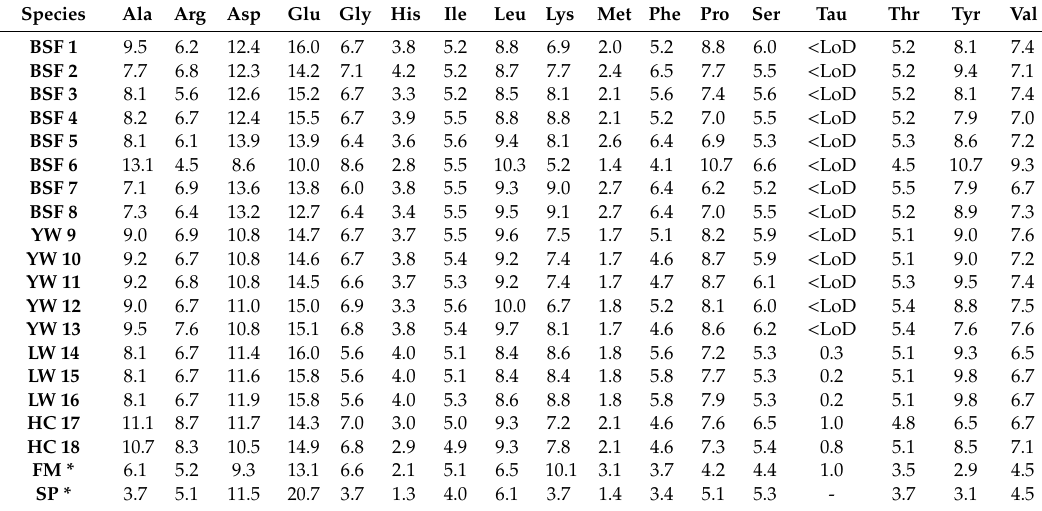
Table 3. Total amino acid composition (% of crude protein) of the 18 insect meal samples. Species Ala Arg Asp Glu Gly His Ile Leu Lys Met Phe Pro